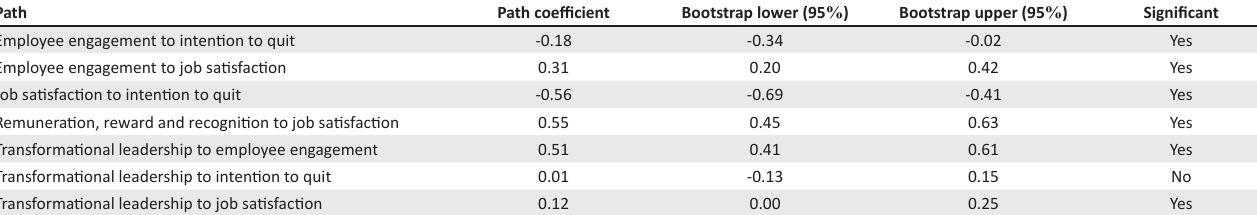
TABLE 7: Partial least squares path modelling results. Path Path coefficient Bootstrap lower (95 % ) Employee engagement to intention to